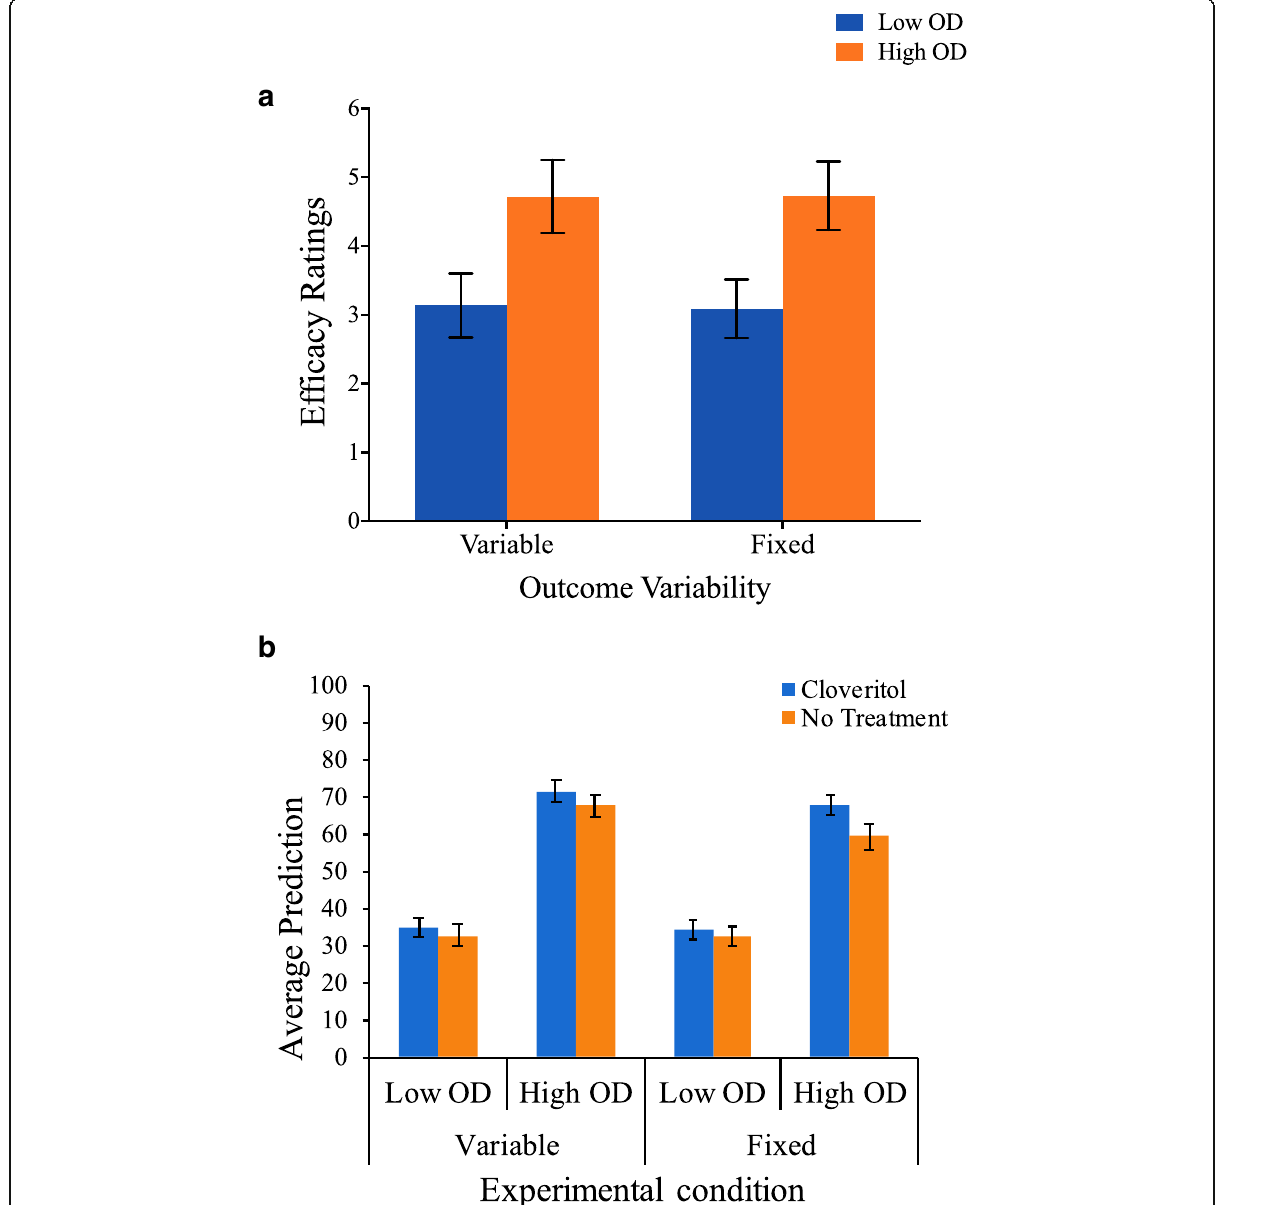
Fig. 3 a Drug efficacy ratings at test (± standard error) as a function of OD and outcome variability. b Average health improvement predictions at test (± standard error) as a function of cue type, OD, and outcome variability. OD outcome